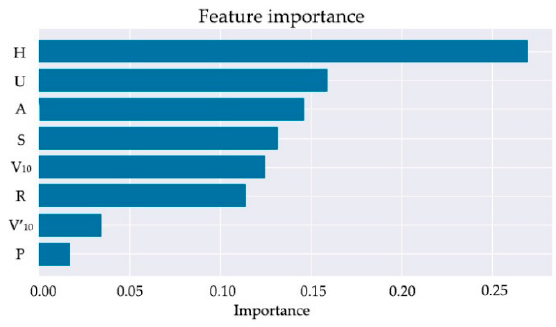
Figure 6. Feature importance ranking.